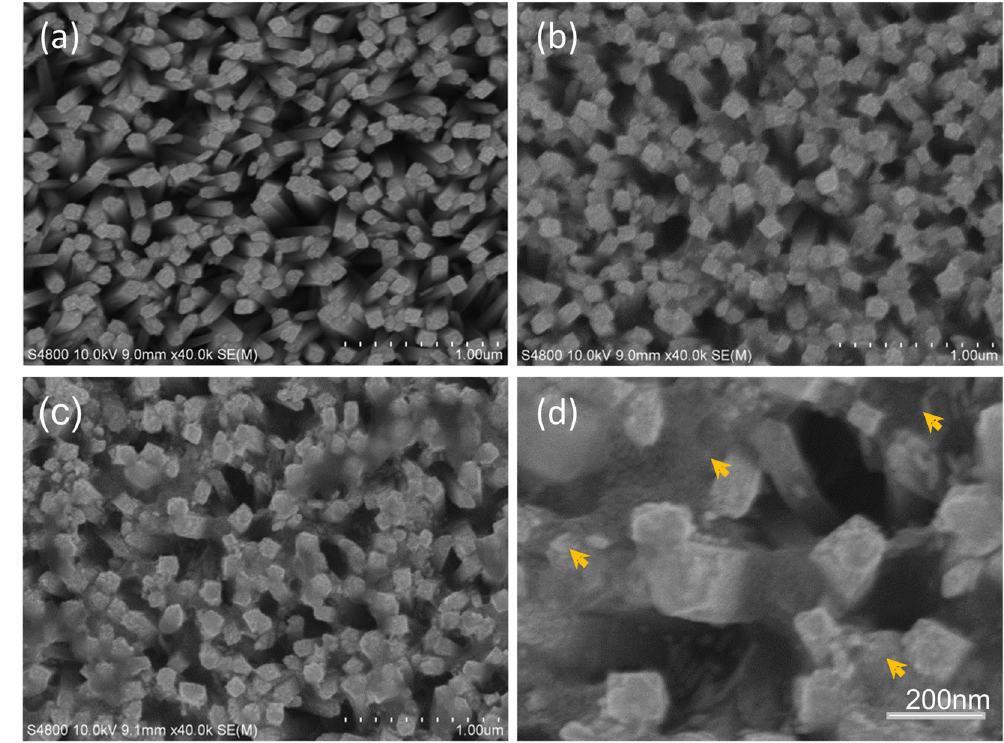
Figure 2. Microscopic structure evolution in prepration of (MoS 2 -TiO 2 )/Au. ( a – d ) Top-view SEM images of TiO 2 ( a ), MoS 2 -TiO 2 ( b ), and (MoS 2 -TiO 2 )/Au ( c , d ). The arrows in ( d ) indictae the locations of Au